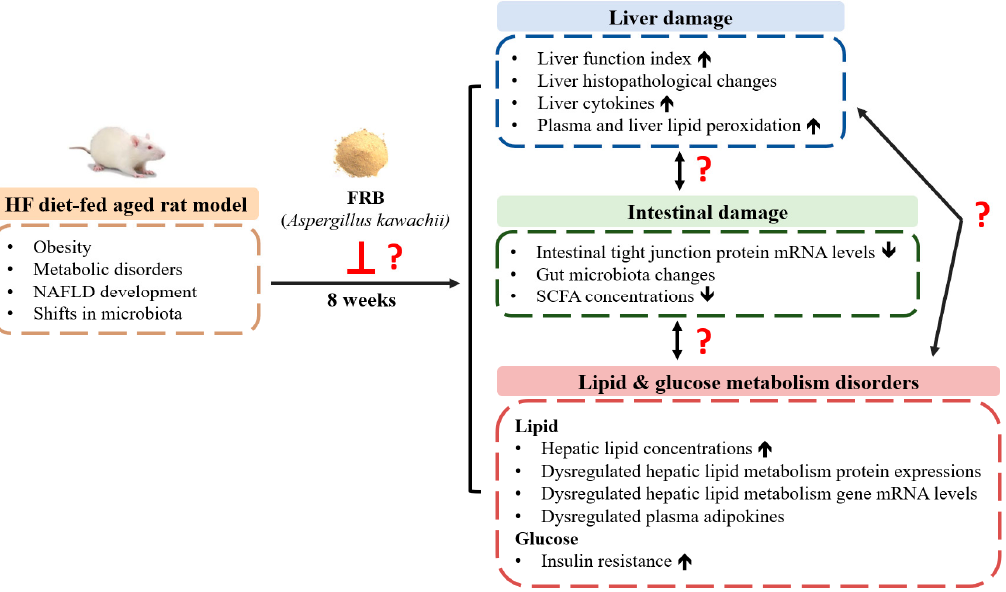
Figure 1. The research motivation and specific aims. NAFLD, non-alcoholic fatty liver disease; HF, high-fat; FRB, water extract of fermented rice bran; SCFA, short-chain fatty acid.